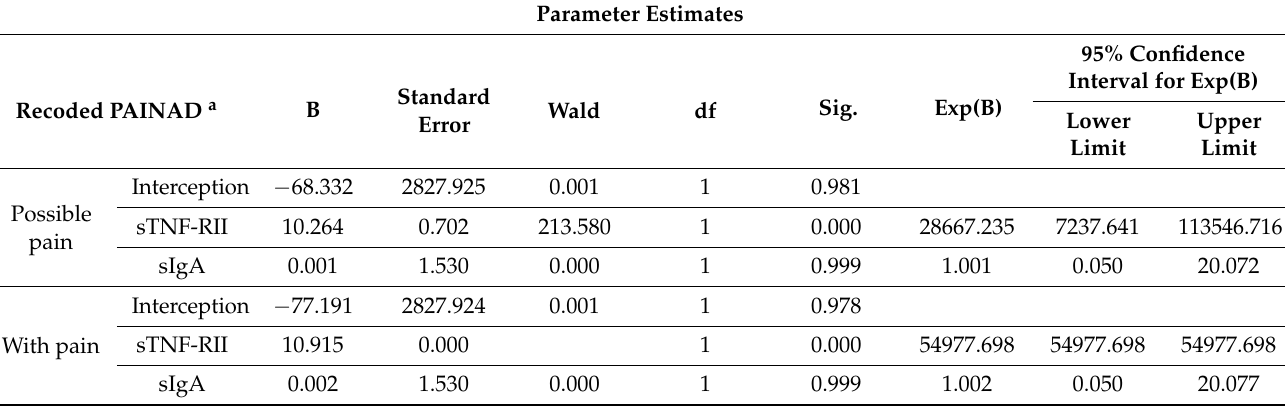
Table 3. Multivariate logistic model between PAINAD score (three categories) and sTNF-RII and sIgA. Parameter Estimates